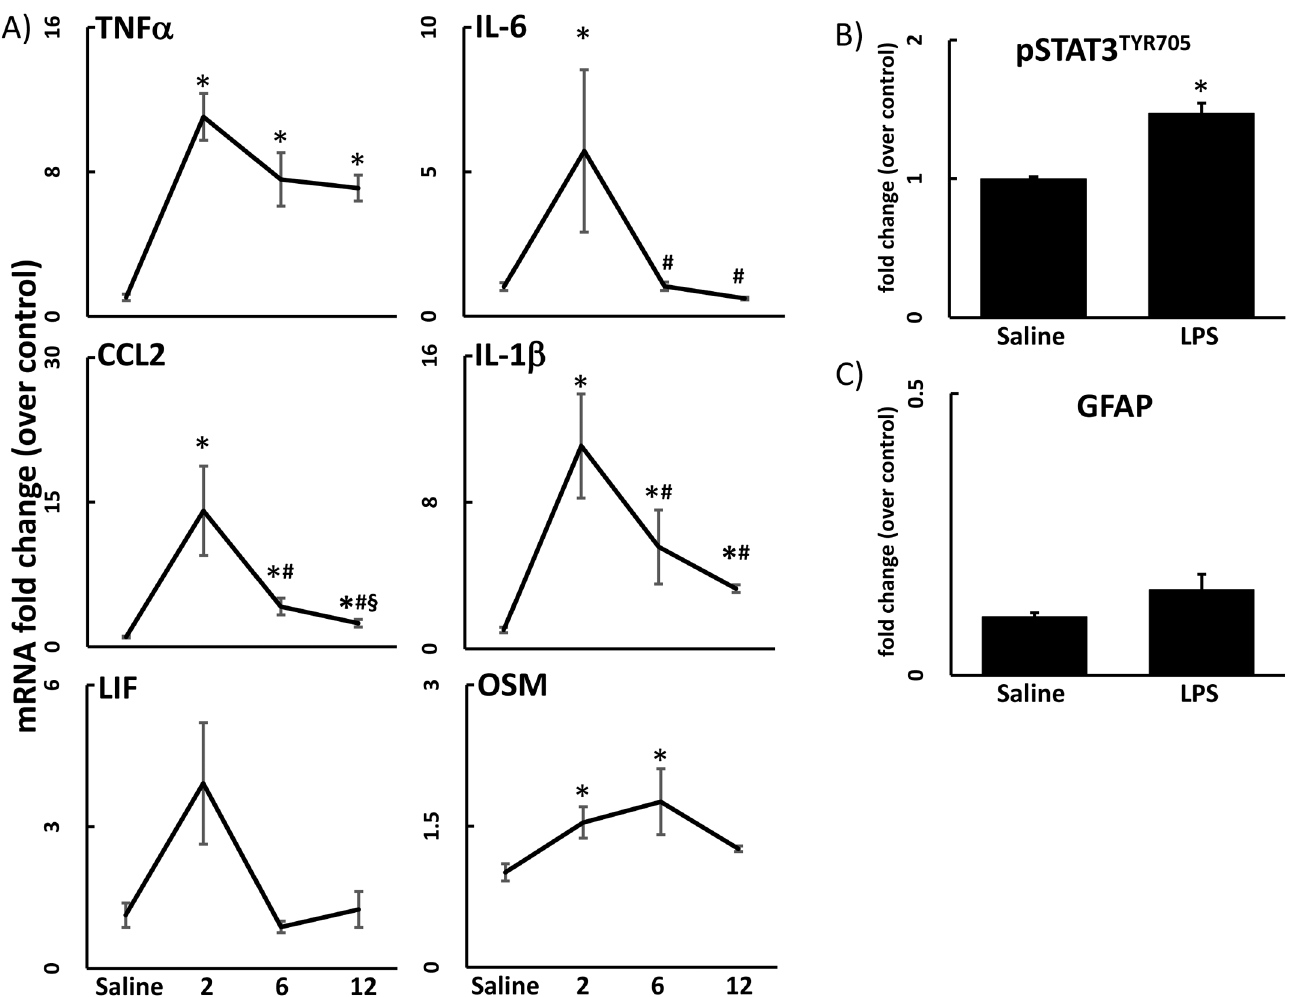
Fig 1. Systemic LPS exposure is neuroinflammatory but does not induce astrogliosis. A) The effects of LPS (2 mg/kg, s.c.) on TNF α , IL-6, CCL2, IL-1 β , LIF, and OSM mRNA levels in samples prepared from cortex were determined at 2, 6, and 12 hours after LPS exposure. Data represents mean ± SEM (n = 5 mice/group). Statistical significance of at least p < 0.05 is denoted by (cid:3) as compared to control, # as compared to 2h LPS, and § as compared to 6h LPS. B & C) The effects of LPS exposure (2 mg/kg, s.c.) on activation of the STAT3 signaling module was assessed by immunoblots of pSTAT3 Tyr705 and astrogliosis was assessed by immunoassay of GFAP. Cortex samples were analyzed for pSTAT3 Tyr705 (6 hours) and GFAP (72 hours) after LPS exposure. Data represents mean ± SEM (n = 5 mice/group). Statistical significance of at least p < 0.05 is denoted by (cid:3) as compared to